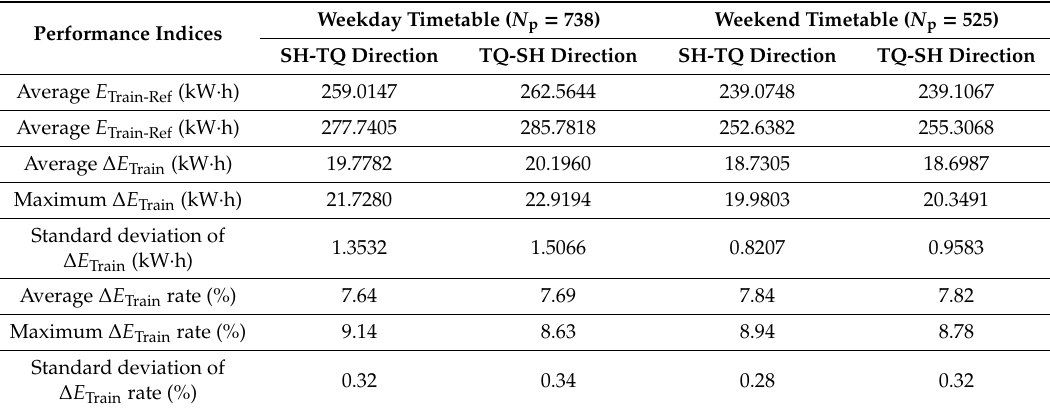
Table 4. Train-level performance comparison results over the reference